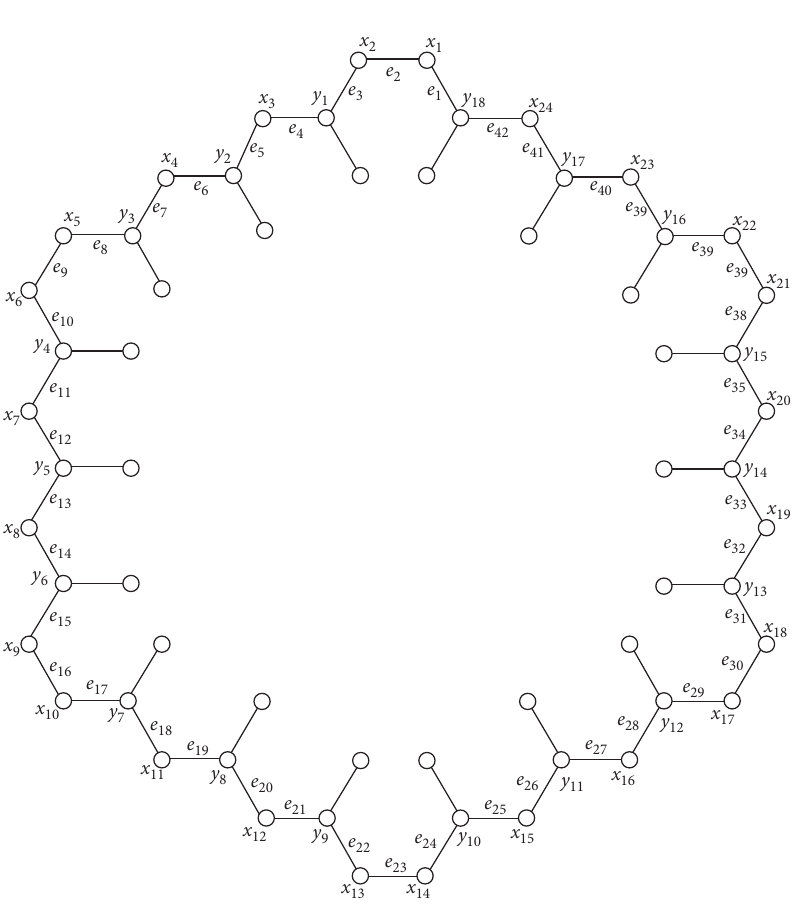
Figure 5: The name of elements of the outer cycle C